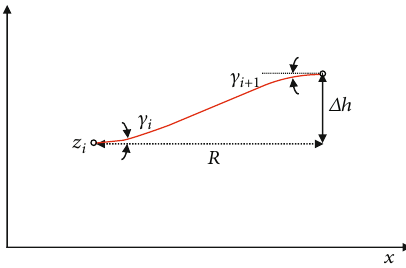
Figure 13: Midcourse guidance trajectory for ascending or descending fl